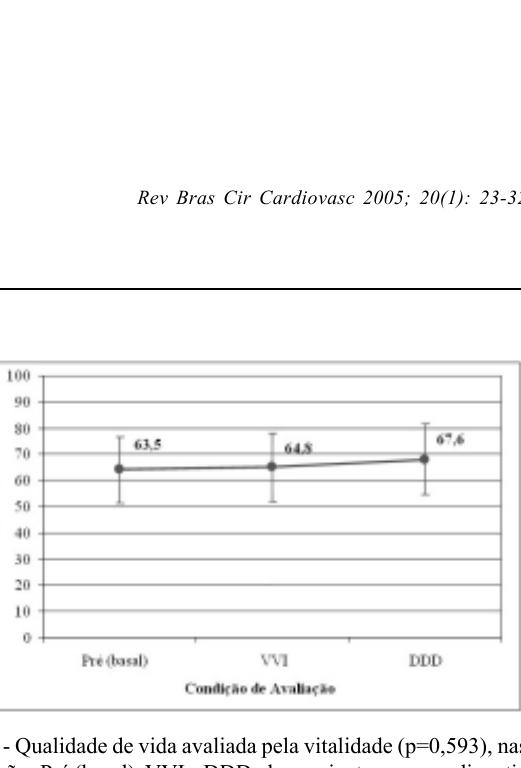
Tabela 2. Avaliação das dimensões de qualidade de vida (Raw Scale), segundo o protocolo SF-36.